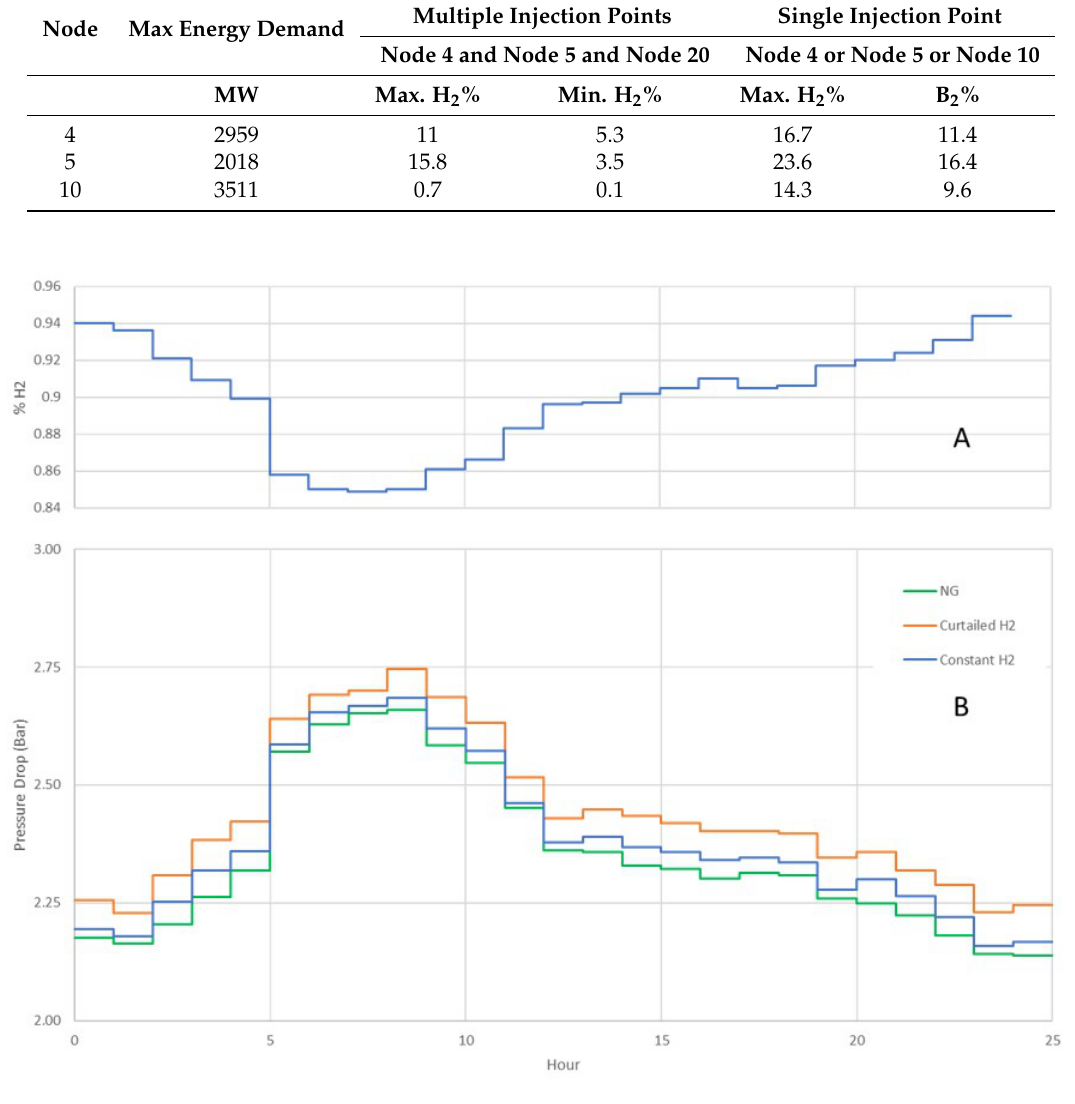
Figure 8. Impact on gas network due to the incorporation of hydrogen from a continuously operating 10 MW electrolyser ( A ) Hydrogen percentage at node 4 ( B ) Pressure drop in Pipe 11 for Natural gas, Hydrogen from curtailed wind, and a constant 10 MW of